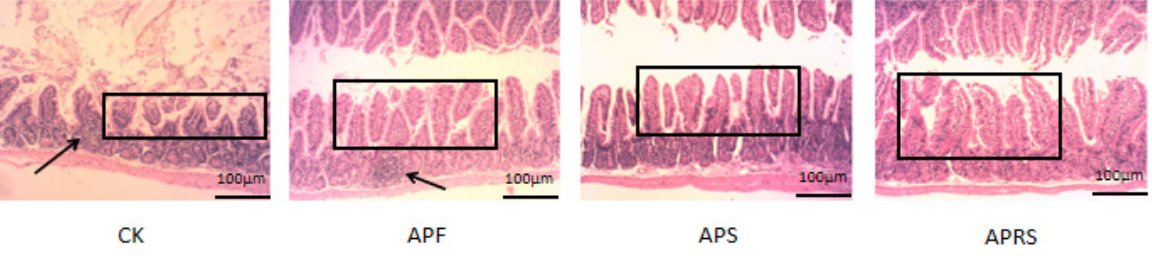
Figure 6. The H&E staining of the jejunum of aged mice after intervention in different groups (mag- nification, 100×). The black arrows show inflammatory cell infiltration; the black squares show the length of the jejunum villus.